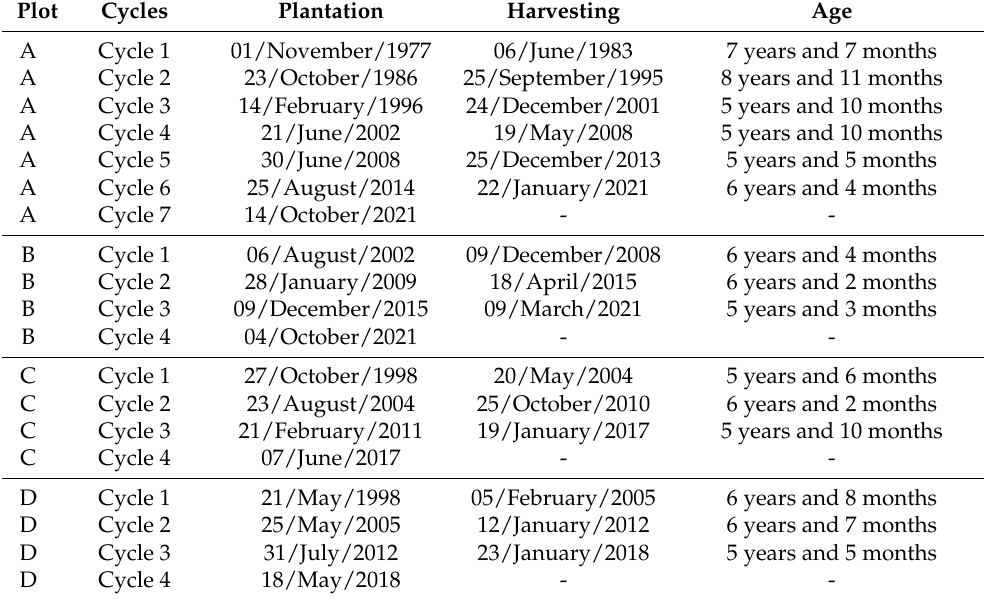
Figure 9. Phenological assessment of eucalypt plantation samples ( A – F ) for 1985–2021 period based on the vegetation, soil, and shade fraction-image time series. Table 5. Eucalyptus rotation cycles according to field data for each selected point in the pilot area.